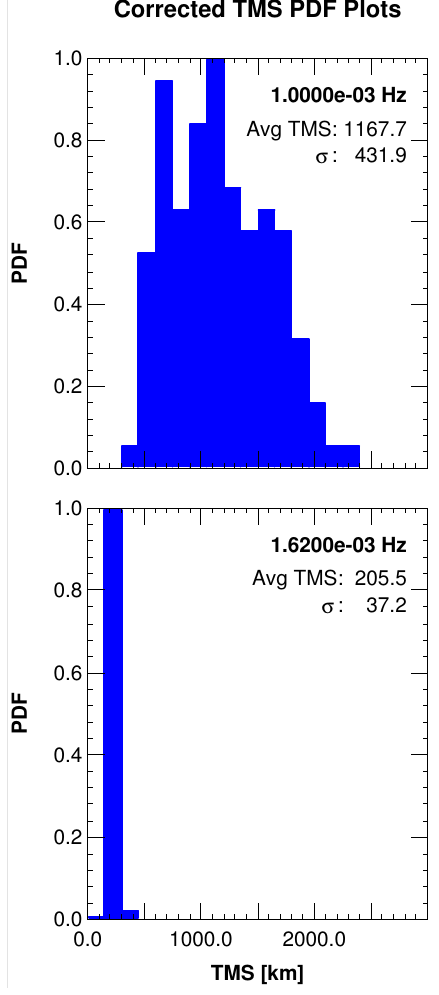
Fig. 6. Probability distribution function of the corrected λ T values at two cutoff frequencies. Both the average λ T and the standard deviation are given in the plot boxes. The bin size is 150 km in both plots.